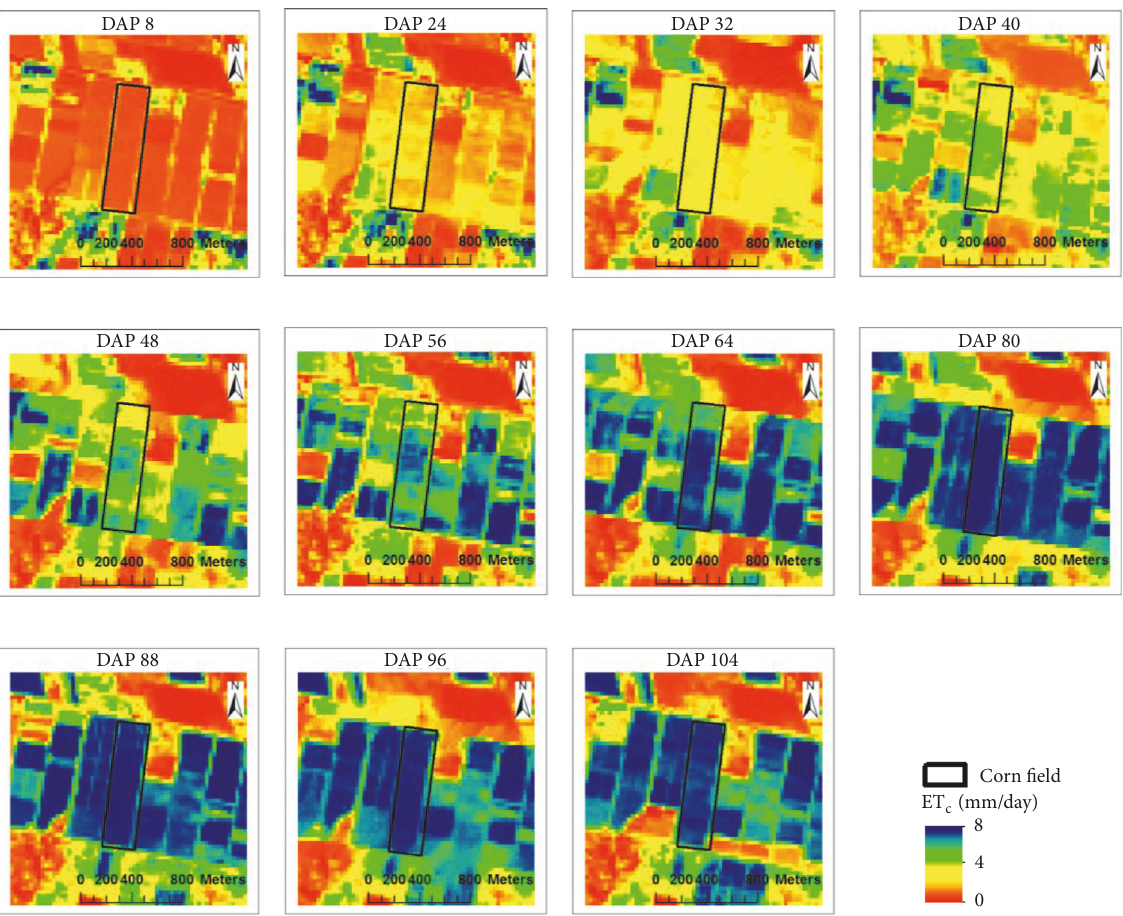
Figure 10: ET maps at a field scale (e.g., silage corn) generated with ERDAS Imagine Software (Model Maker) and ArcGIS version 10.3.1 c using Landsat 7 and Landsat 8 satellite images for the 2014 growing season. The red, light green, and dark blue colors within the corn field (black rectangle) indicate low, medium, and high ET c